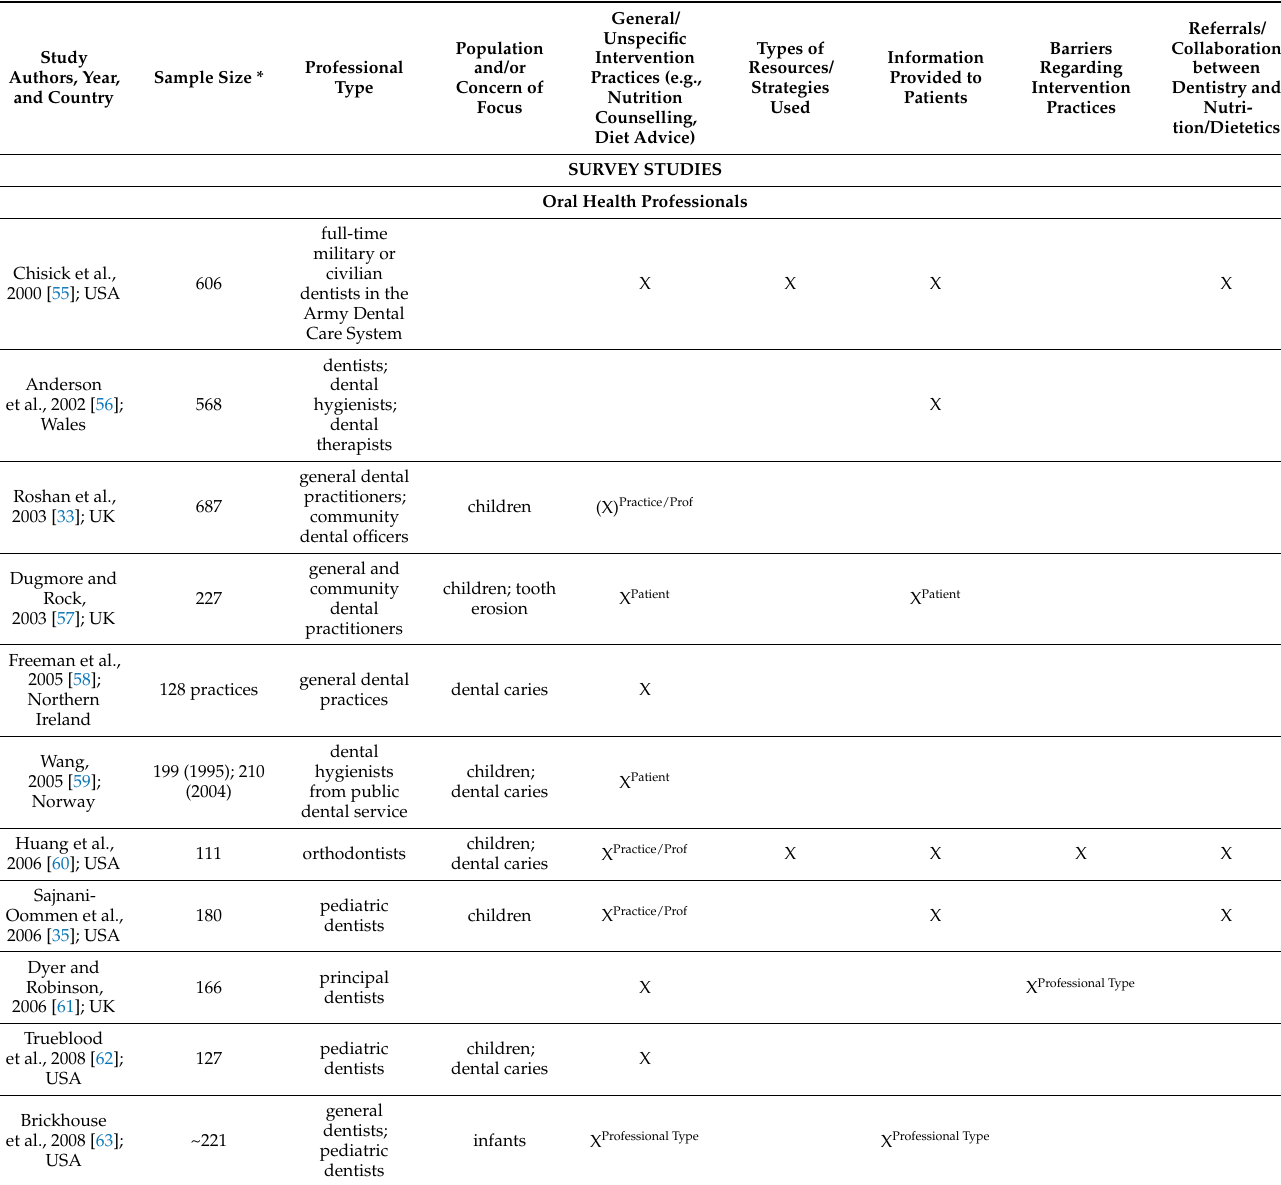
Table 4. Intervention practice information reported in the included